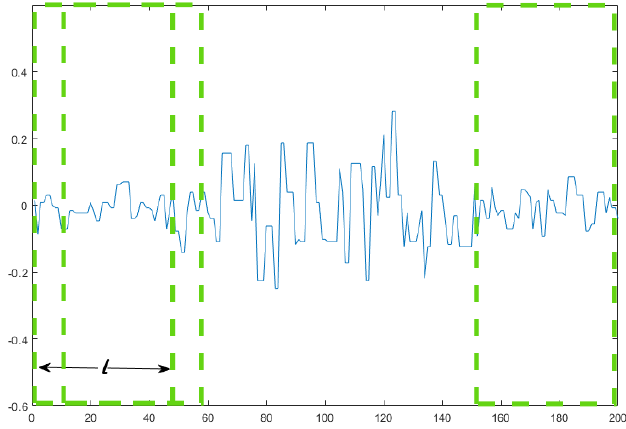
Figure 5. The sliding window extracts signal segments of muscle activity regions on one channel.